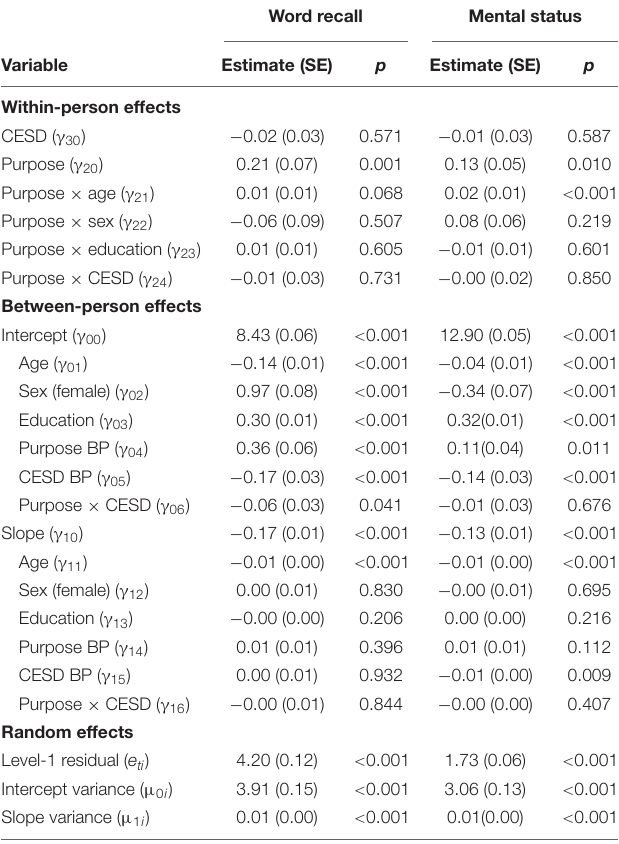
TABLE 2 | Multilevel models for sense of purpose and depressive symptoms as a predictor of word recall and mental